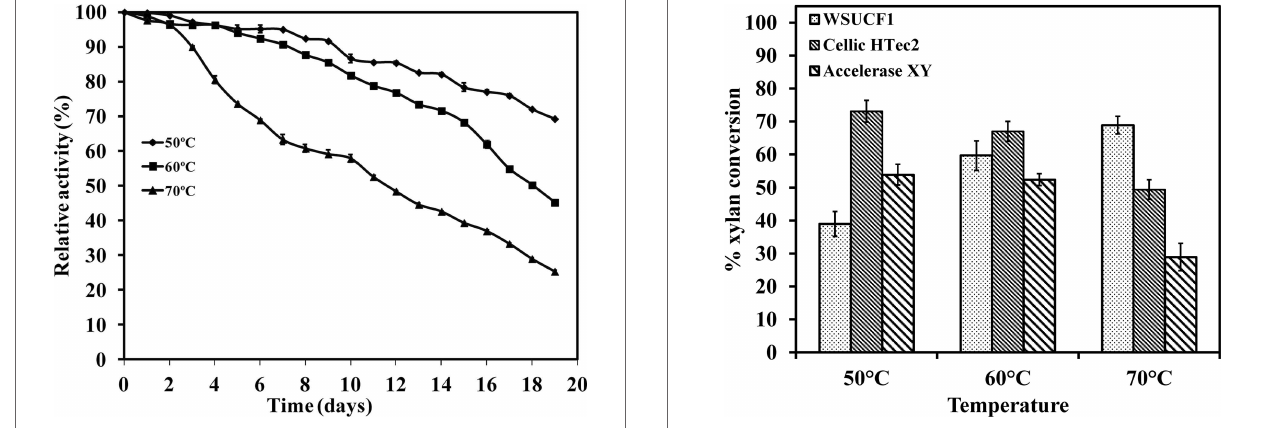
FigUre 5 | Thermal stability of xylanase activity produced by WsUcF1 isolate . The enzyme activities were expressed as percentages of the initial activity. The points are the averages of triplicates, and error bars indicate ± SDs of the means ( n = 3). Error bars smaller than the symbols are not shown.